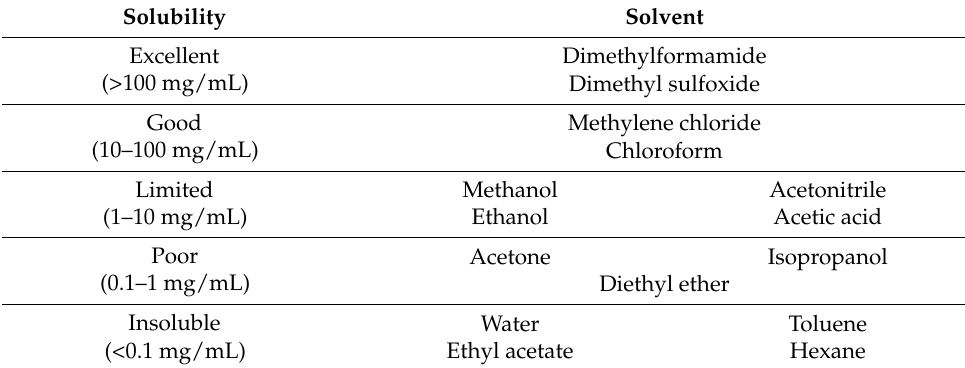
Table 2. Solubility of 8-FUmb and 6-FUmb